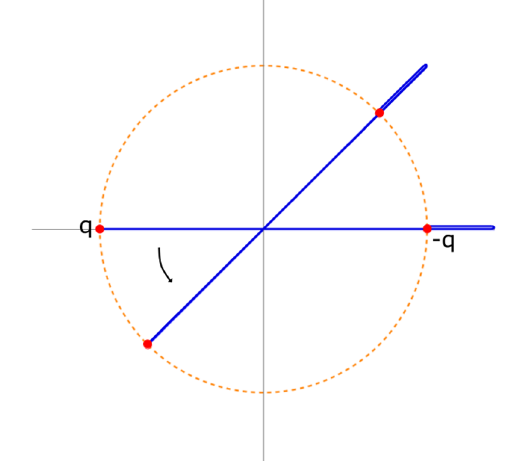
Figure 3 . The rotating solution of a neutral string with endpoint charges in a magnetic (cid:12)eld. The charges rotate around the central point between them. The magnetic (cid:12)eld is in the z direction, coming out of the plane, and the rotation is